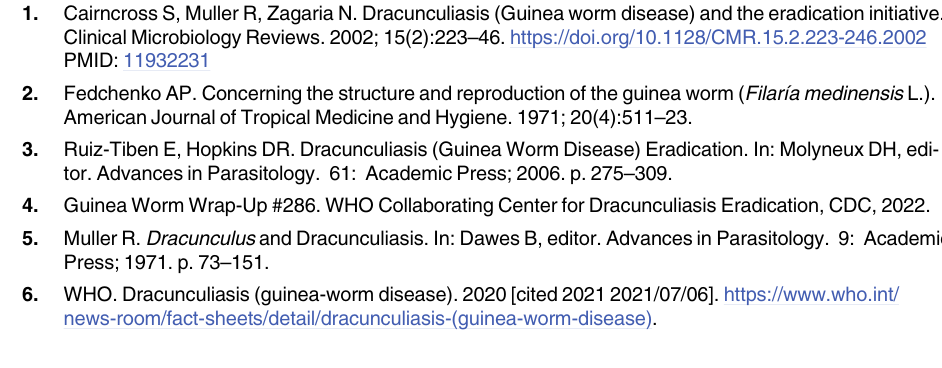
S1 Table. Primers and probe targeting the mitochondrial cytochrome c oxidase subunit 3 ( cox3 ) gene of Guinea worm ( Dracunculus medinensis ) for qPCR amplification and devel- opment of a gBlock